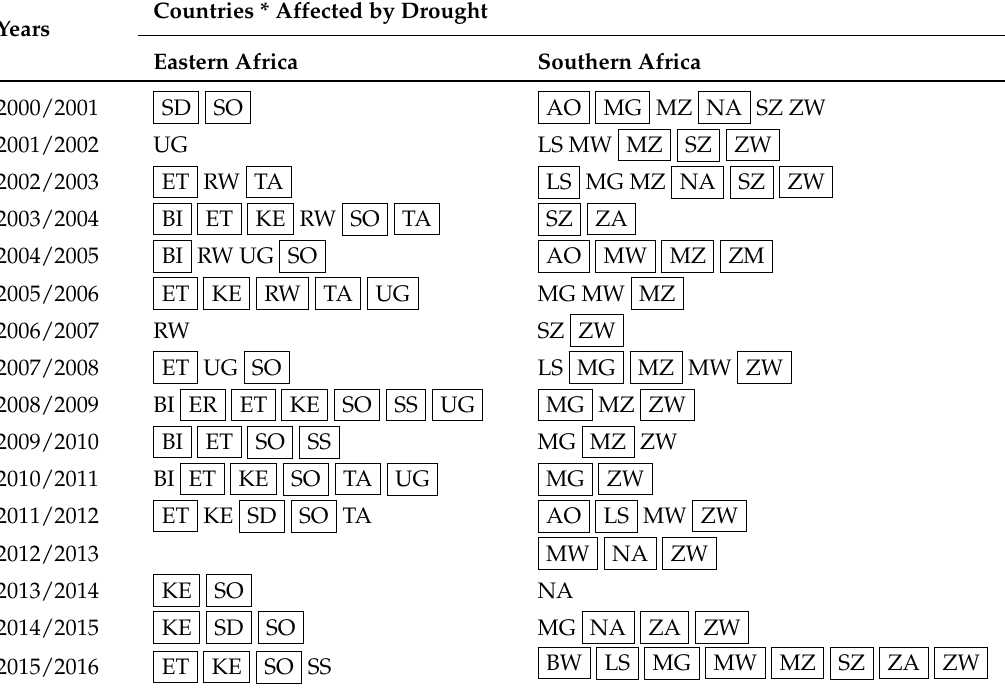
Table 4. Seasonal years and countries of focal regions affected by extensive droughts according to the EM-DAT disaster database [8]. Framed years are in agreement with revealed SPI-3- and VCI-based results (see Table 3).